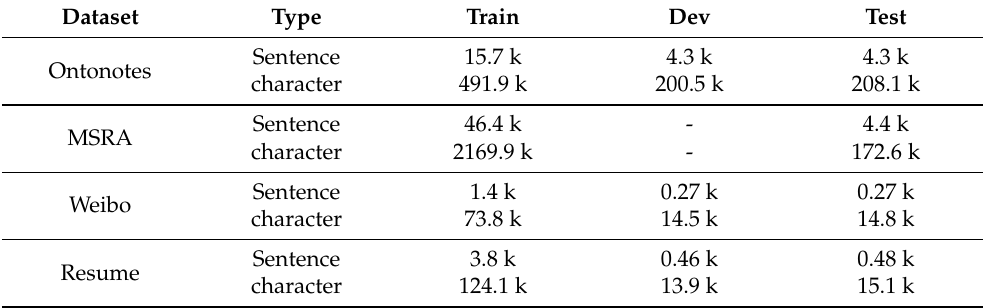
Table 1. Statistics of